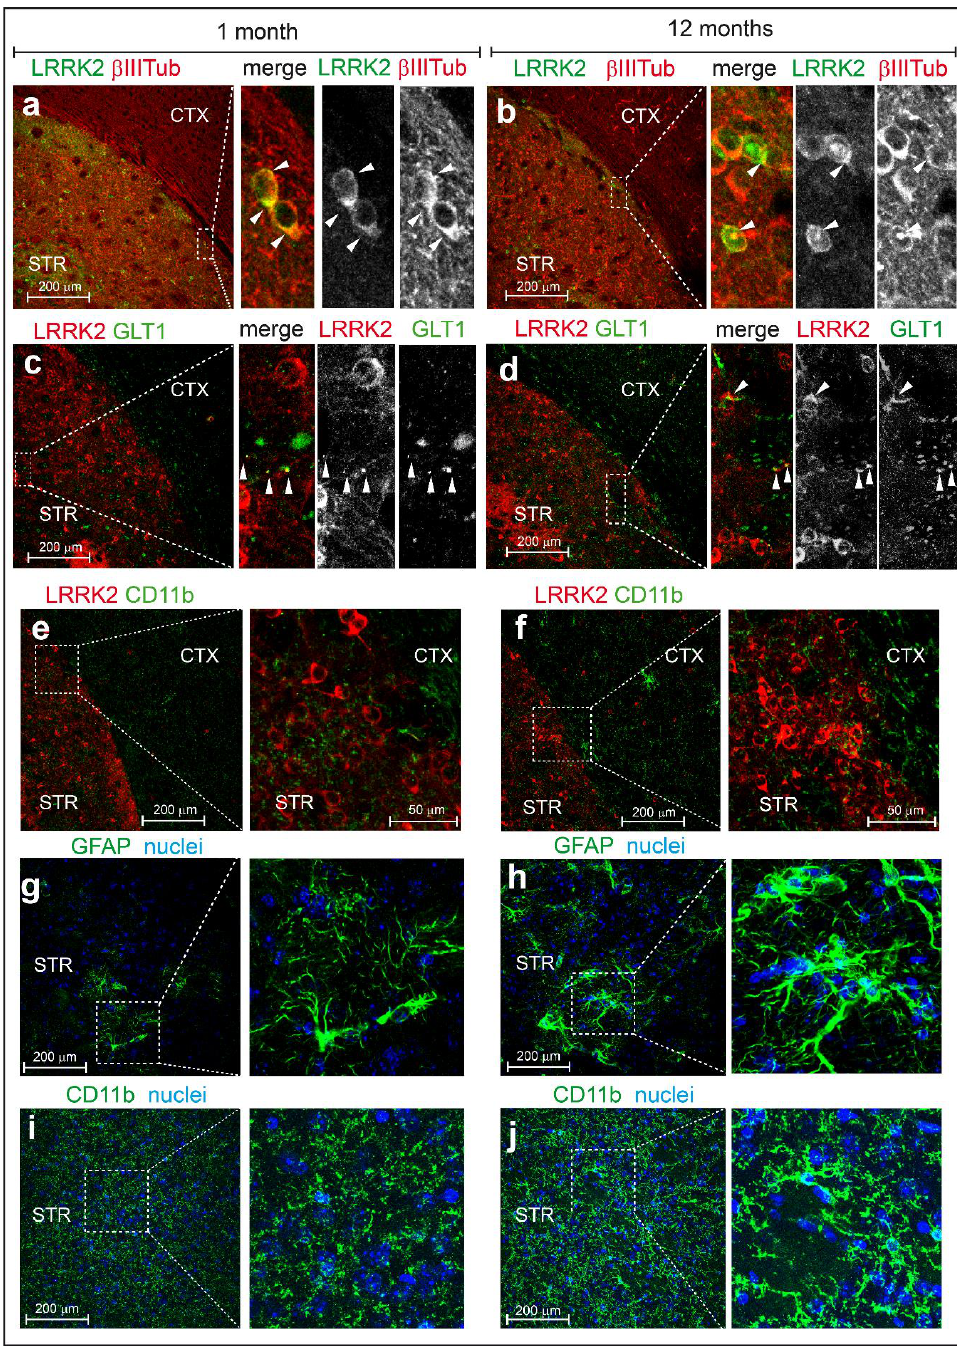
Figure 5. Immunofluorescent analysis of Lrrk2 distribution and subcellular localization in mBAC-Lrrk2-G2019S brain. Representative co-immunofluorescent staining of brain slices from hemizygous transgenic mice overexpressing murine BAC-Lrrk2-G2019S. In detail: ( a , b ) tot-Lrrk2 (green) distribution in cortex and striatum and subcellular localization in β -III-tubulin positive neurons (red) of 1-month-old and 12-months-old mice; ( c , d ) tot-Lrrk2 (red) distribution in cortex and striatum and subcellular localization in GLT-1 positive astrocytes (green) of 1-month-old and 12-months-old mice; ( e , f ) tot-Lrrk2 (red) distribution in cortex and striatum and subcellular localization in CD11b positive microglia (green) of 1-month-old and 12-months-old mice. Representative immunofluorescent staining of ( g , h ) GFAP and ( i , j ) CD11b-positive cells highlighting the different shape and activation level of striatal astrocytes and microglia respectively, at 1 and 12 months of age. n = 3 animals each staining. Scale bars 200 µ m, and 50 µ